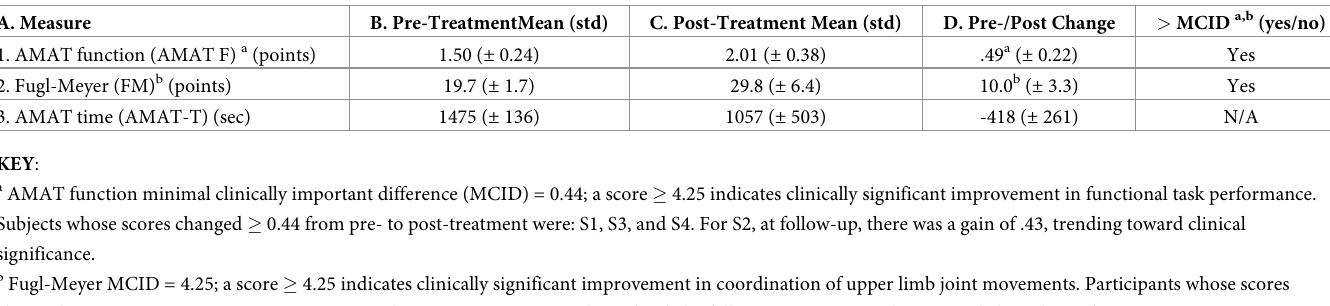
adults were as follows: 6 males and 4 females, average age 43.8 ± 22.9 years, all right-handed except one male. There were no study-related adverse events.